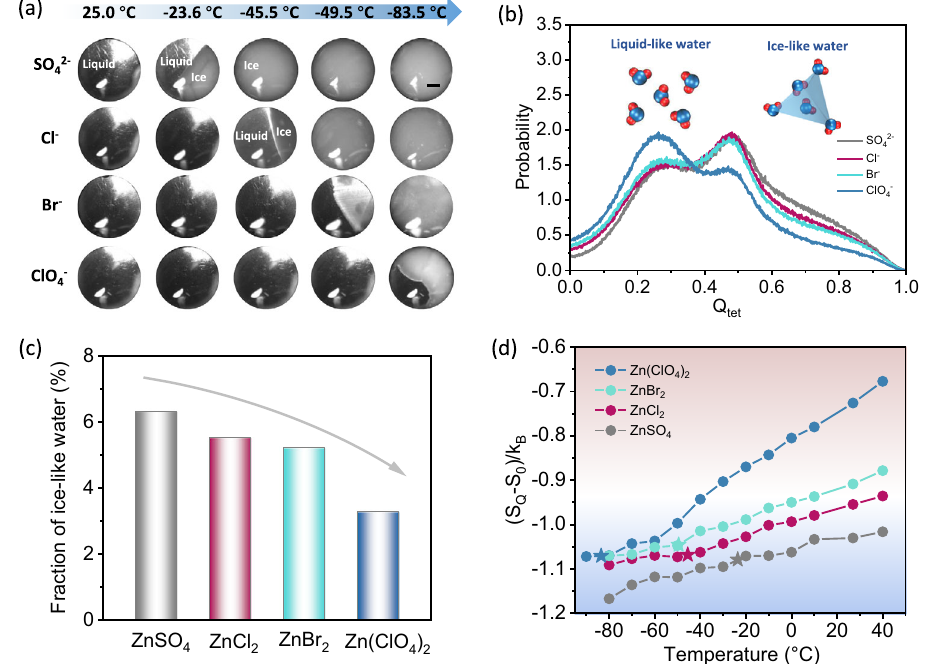
Fig.3|Theoreticalandexperimentalanalysisofthermodynamicpropertiesof water in differentelectrolytes. a In situ optical microscopic observations offour electrolytes(5m)beforeandafterfreezing.Blackscalebar,1mm. b Theprobability distributions of the tetrahedral order parameter Q tet for water molecules in dif- ferentelectrolytesat25°C.Insetshowstheschematicmodelsofliquid-likeandice-